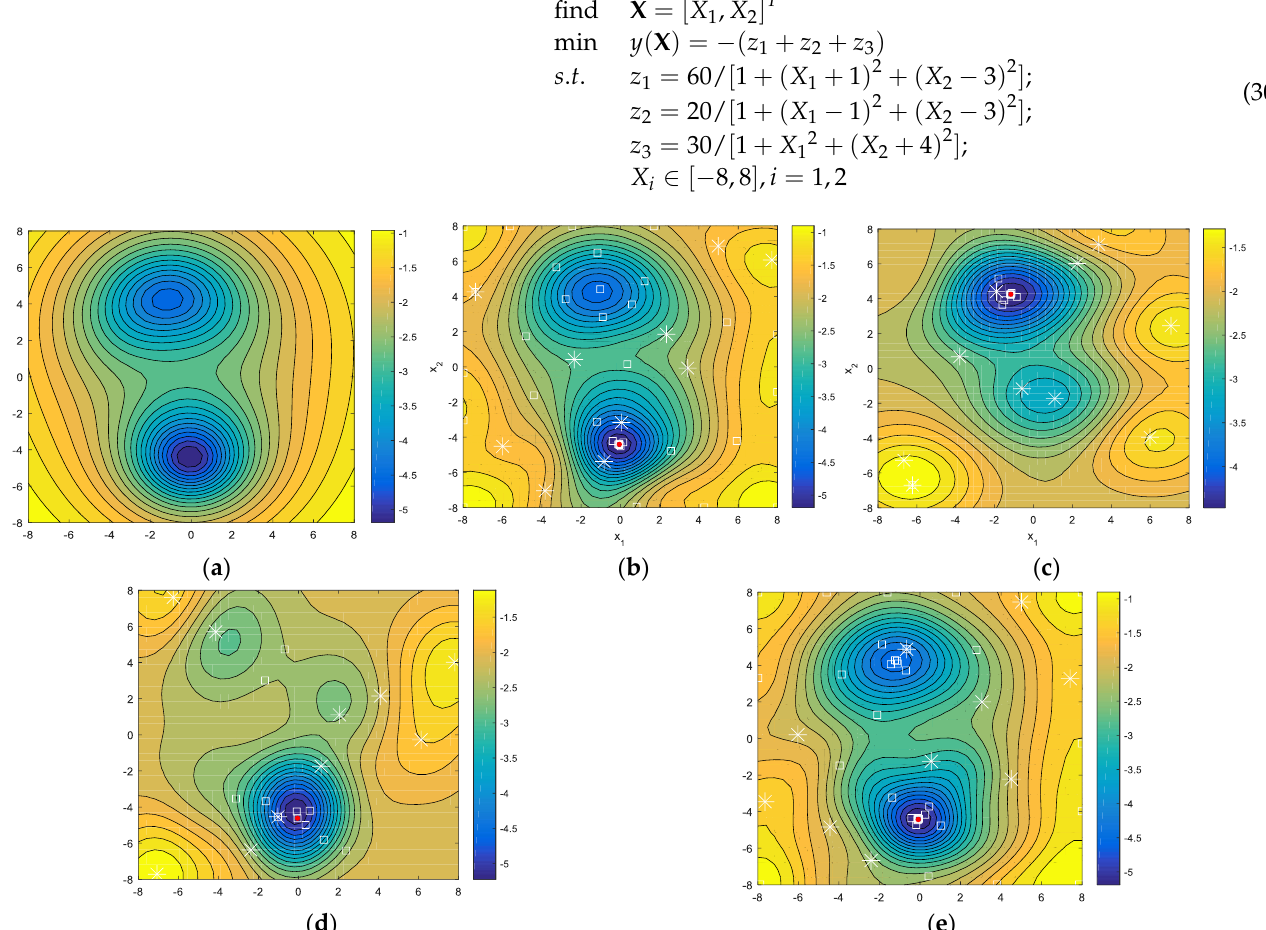
Figure 2. Search history of double-peak function by ( a ) Original function, ( b ) Predictive function by EID, ( c ) Predictive function by EIE, ( d ) Predictive function by AIC, ( e ) Predictive function by PAIC, where asterisk (*) denotes the original points, square (□) denotes the additional training points, red dot denotes the predictive global optimum.